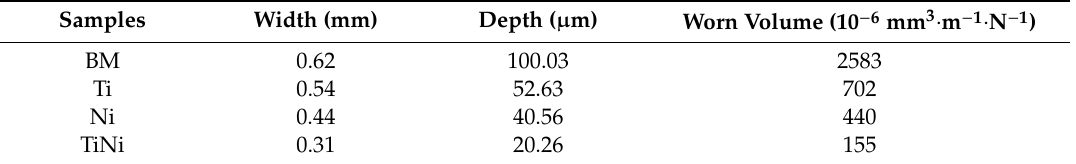
Table 1. Worn volume results of different samples.